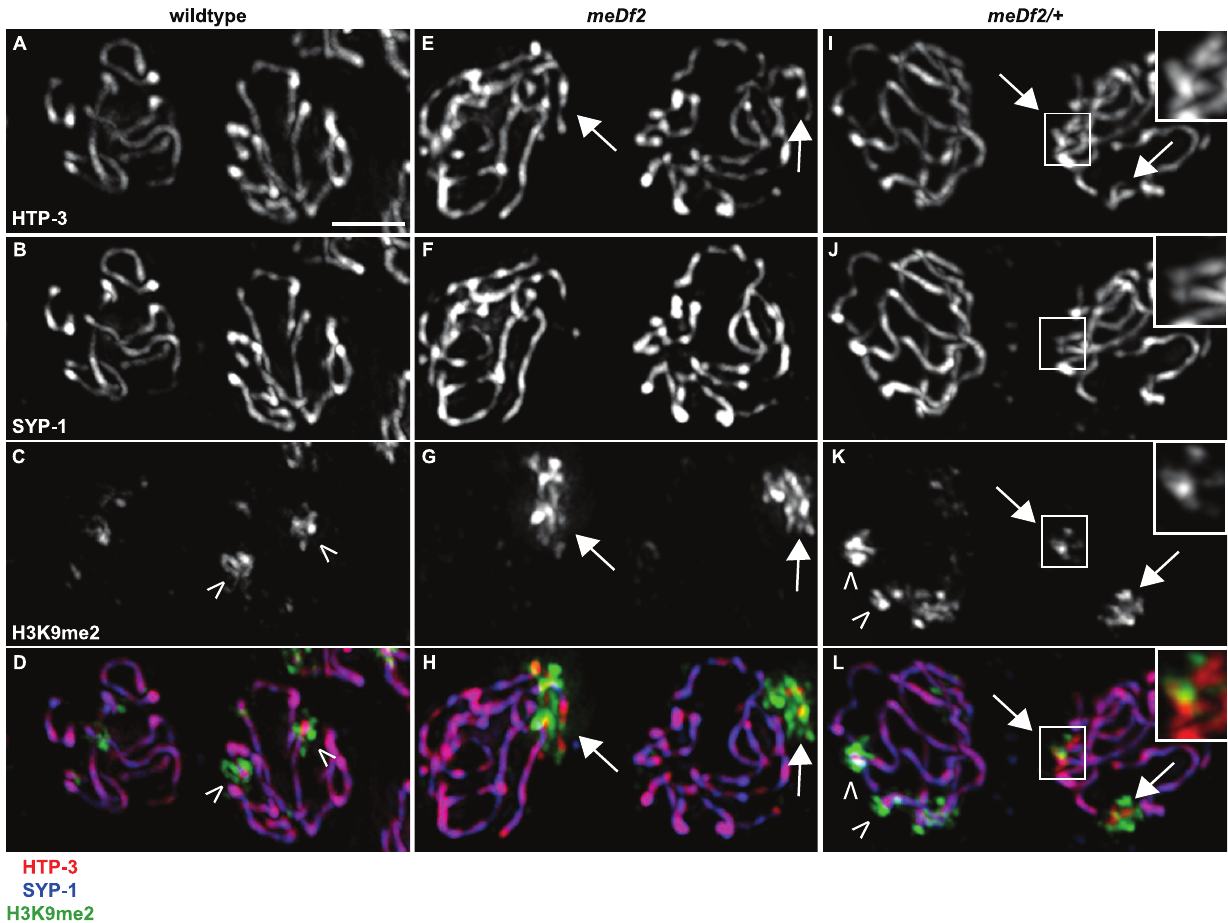
Figure 1. H3K9me2 is enriched on unsynapsed chromosomes when either the DNA damage checkpoint or the synapsis checkpoint is activated. Indirect immunofluorescence was performed on meiotic nuclei in wildtype, meDf2 homozygotes and meDf2 heterozygotes using antibodies against the axial element component HTP-3, the central element component SYP-1 and H3K9me2. Wildtype meiotic nuclei exhibit colocalization of HTP-3 and SYP-1 (A, B and D), and have areas of H3K9me2 enrichment (carets) and depletion (C and D). Meiotic nuclei in both meDf2 homozygotes and meDf2 heterozygotes have chromosomes with HTP-3 but not SYP-1 (arrows in E, F, H, I, J and L, magnified insets in I, J and L). These are unsynapsed X chromosomes and are highly decorated with H3K9me2 (G, H, K and L, magnified insets in K and L). Other regions of H3K9me2 enrichment are also observed in nuclei with synapsed chromosomes in meDf2 heterozygotes (carets in K and L). Scale bar represents 4 microns.